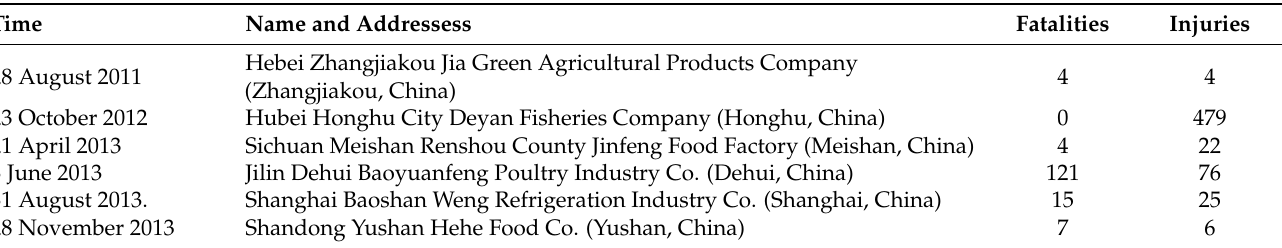
Table 2. Typical cases of ArRAs.